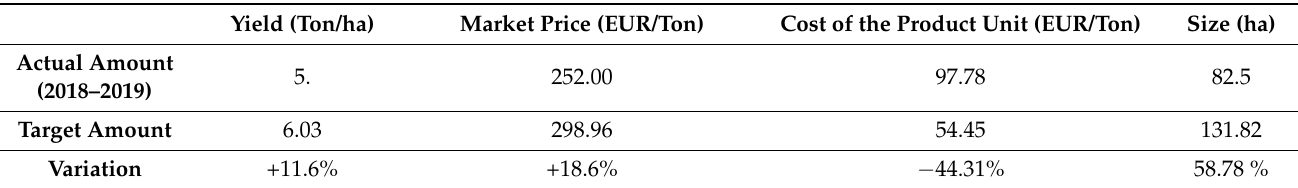
Table 4. Durum wheat sensitivity